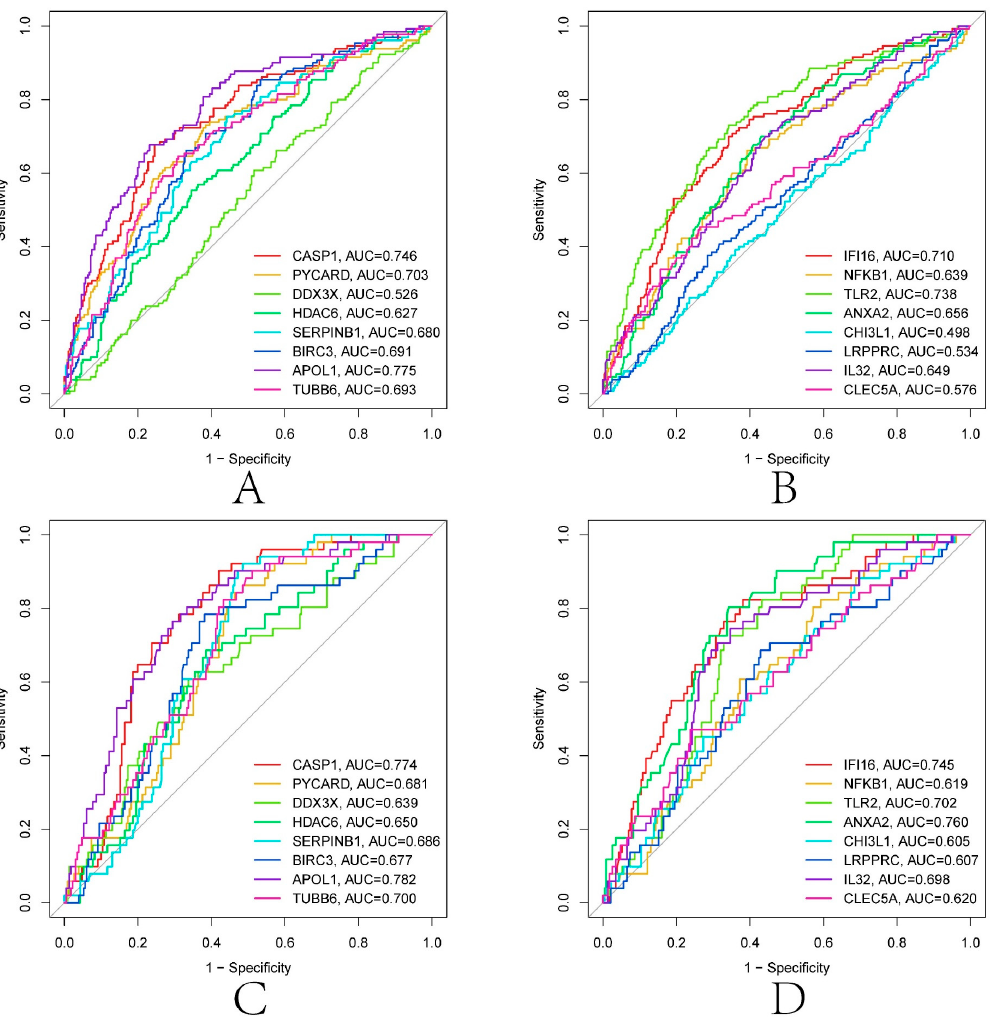
Figure 8. Diagnostic performance of 16 diagnosis related genes in GSE21374 and GSE36059. ( A , B ) GSE21374. ( C , D ) GSE36059.